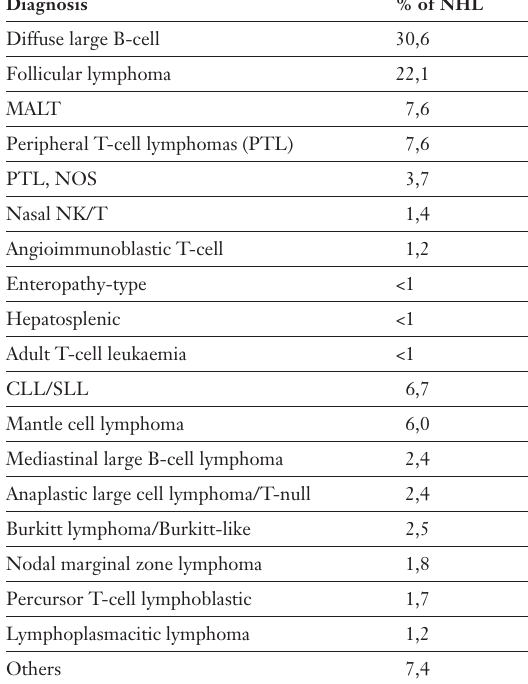
Incidence of lym-